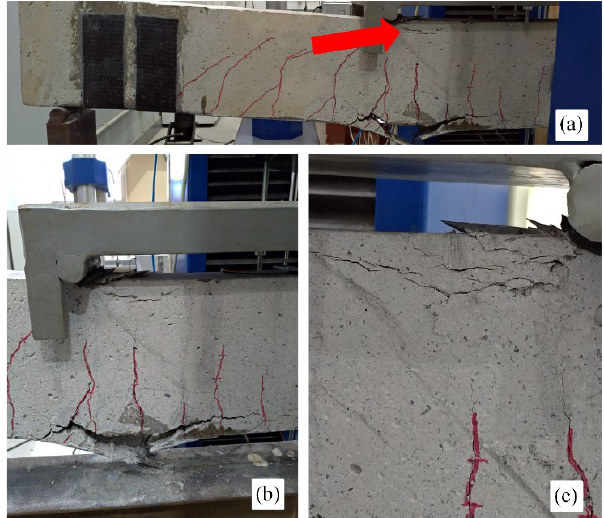
Figure 19. Failure of beam CR80-I2 (a); Detail of the crushed concrete and of the CFRP sheet rupture (b); Magnified detail of the crushed concrete (c).